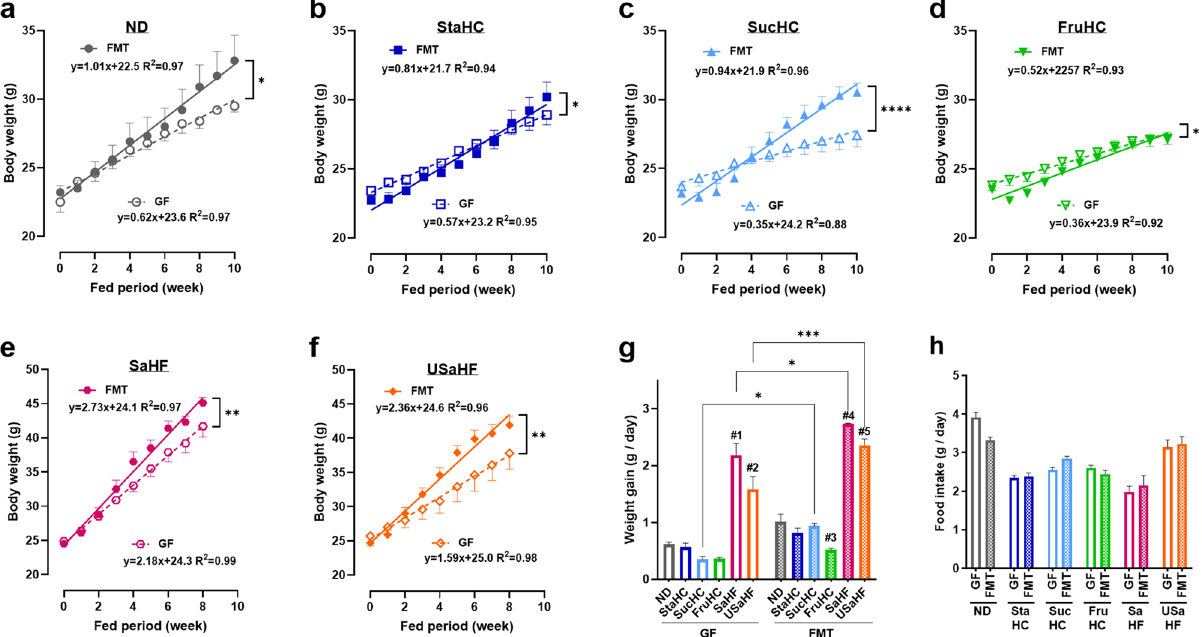
Figure 1. Difference in body weight between germ-free (GF) and fecal microbiota transplant (FMT) mice fed six different diets. The diets included ( a ) ND (n = 4), ( b ) StaHC (n = 7), ( c ) SucHC (n = 4), ( d ) FruHC (n = 7), ( e ) SaHF (n = 4), and ( f ) USaHF (n = 4). Values are presented as the mean ± SEM. Linear regression lines were compared using a two-tailed analysis of covariance. ( g ) Amount of weight gain/day. ( h ) Amount of food intake/d. Multiple comparisons were analyzed using a two-way analysis of variance with the Bonferroni post- hoc test. Asterisks (*) indicate significant differences between GF and FMT (* p < 0.05, ** p < 0.01, *** p < 0.001, and **** p < 0.0001). The # denotes the following significant differences between the diet groups: #1 p < 0.0001, SaHF vs ND, StaHC, SucHC, and FruHC; #2 p < 0.0001, USaHF vs ND, StaHC, SucHC, and FruHC; p < 0.01, USaHF vs SaHF; #3 p = 0.016, FruHC vs ND; #4 p < 0.0001, SaHF vs ND, StaHC, SucHC, and FruHC; #5 p < 0.0001, USaHF vs ND, StaHC, SucHC, and FruHC. ND normal diet, StaHC high-starch diet, SucHC